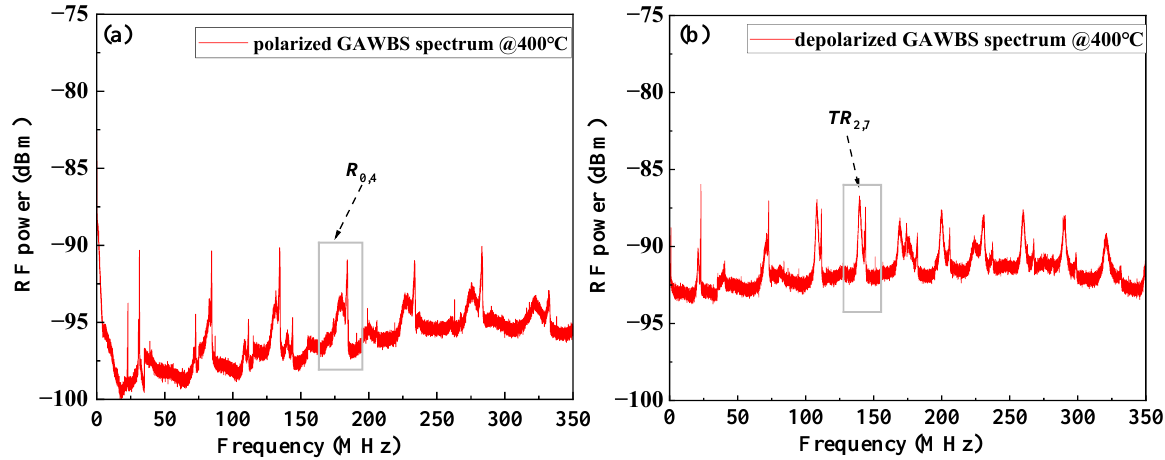
Figure 2. Measured polarized ( a ) and depolarized ( b ) GAWBS spectrum at 400 °C . Table 1 . Calculated and measured resonance frequencies of the polarized and depolarized GAWBS in silica